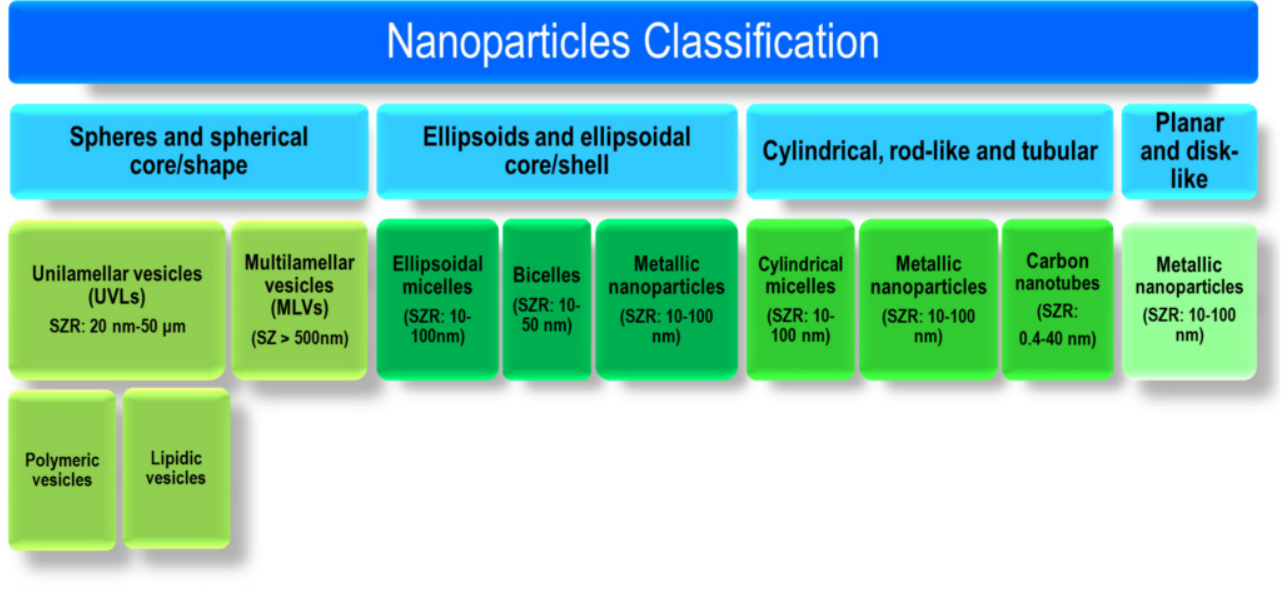
Figure 2. Classification of nanoparticles according to their